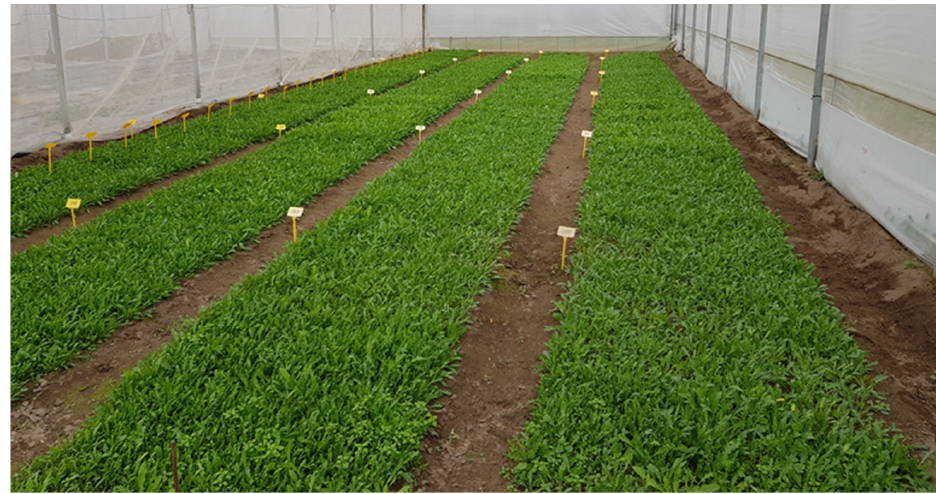
Figure 3. Experimental field trial consisting of a baby-leaf wild rocket cultivation carried out under greenhouse located at the CREA-Research Center for Vegetable and Ornamental Crops.